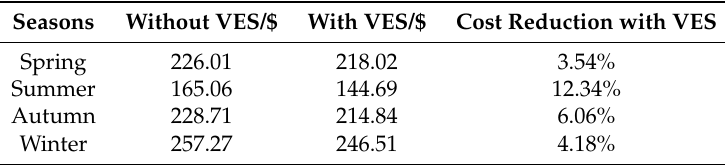
Figure 13. The optimal scheduling results in winter: ( a ) VES is not considered; ( b ) VES is considered. Table 5. Daily operating costs of the system under 4